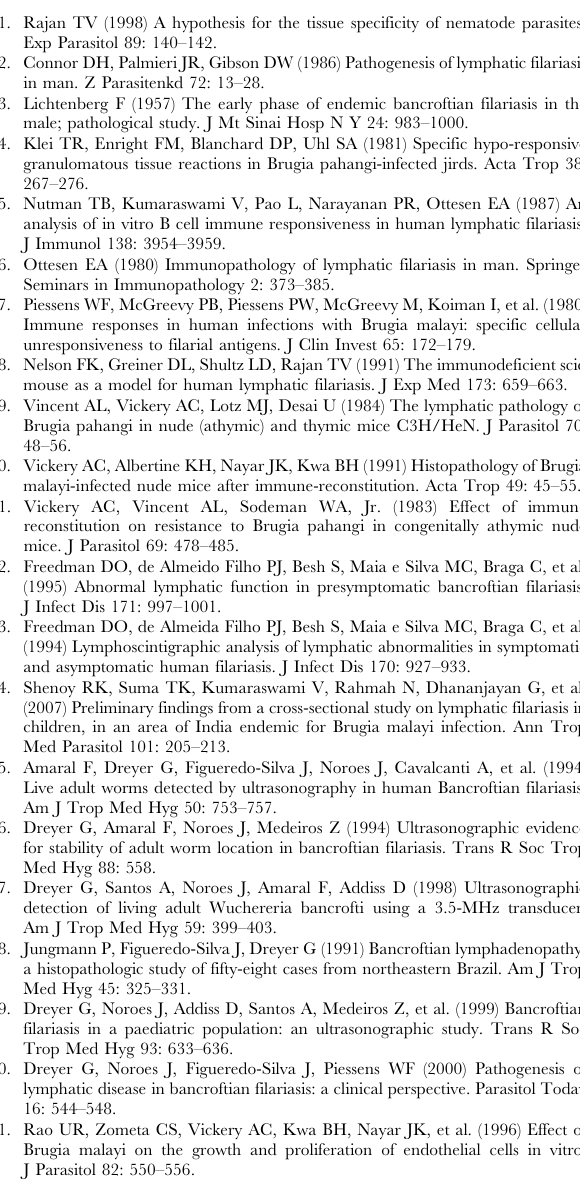
Table S1 List of genes targeted for qRT-PCR used to evaluate gene